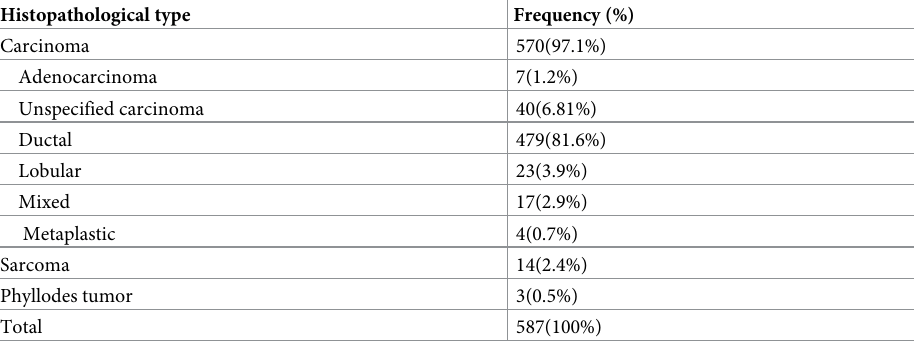
Table 2. Histopathological classification of breast cancer, 2014–18,